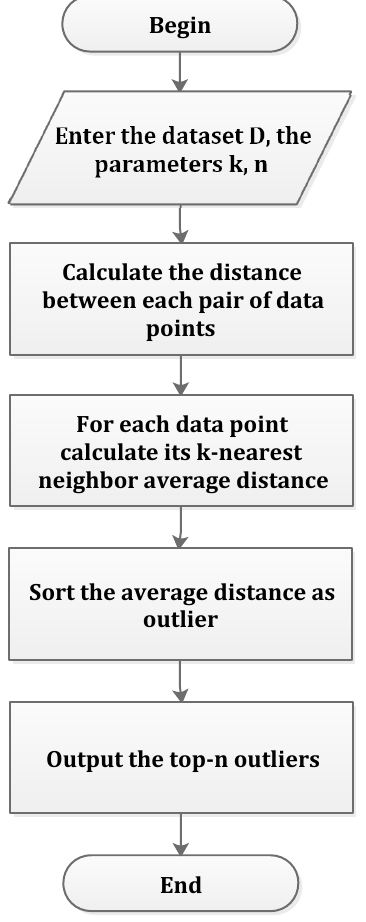
Figure 3. Outlier detection algorithm based on